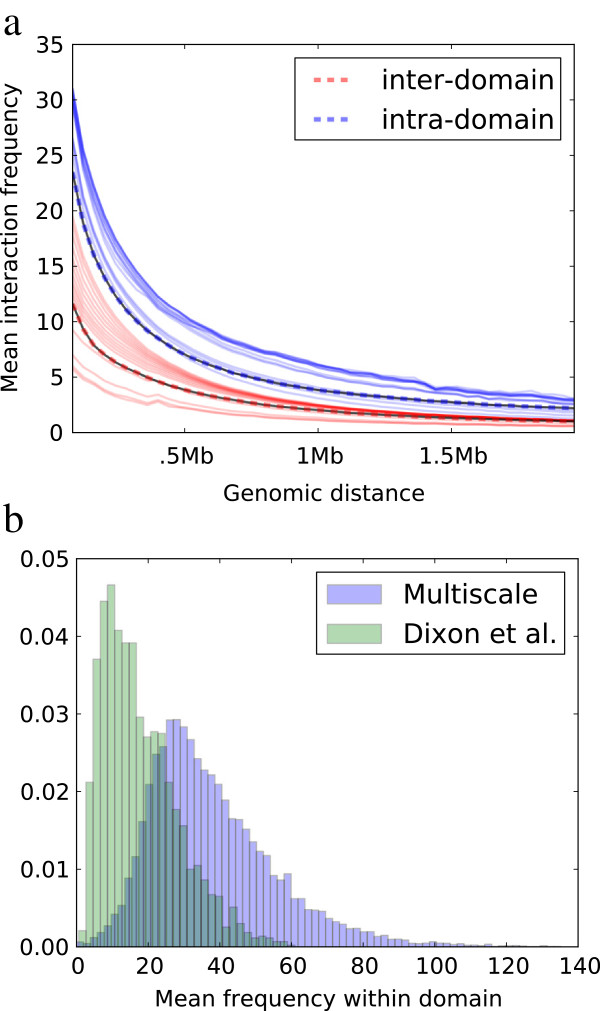
Our approach identifies densely interacting domains across scales.(a) Our algorithm discovers domains with mean frequency value for inter- and intra-domain interactions (solid lines) at or better than that of Dixon et al. domains (dotted lines). Each solid line represents domains at different resolution γ in human fibroblast cells. (b) Multiscale domains identified in human fibroblast cells by our dynamic program tend to have higher mean frequency than those of Dixon et al. (distributions are plotted after outliers >μ+4σ were removed).